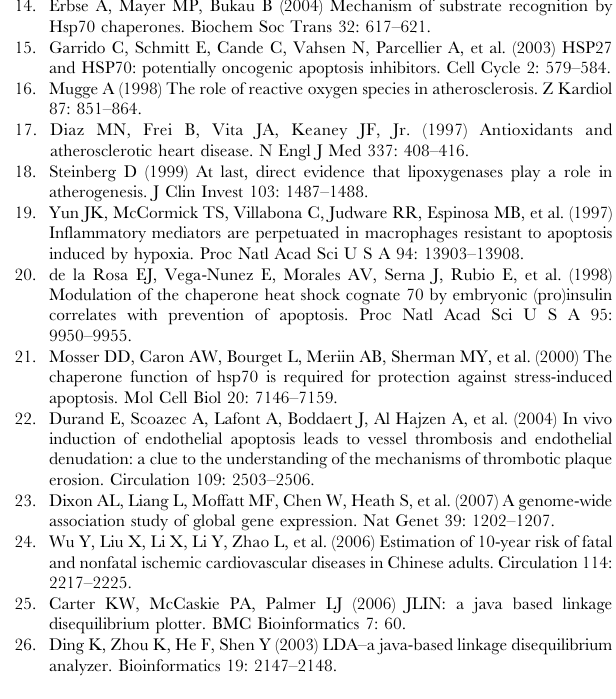
Table S3 Primer sequences used in amplification and